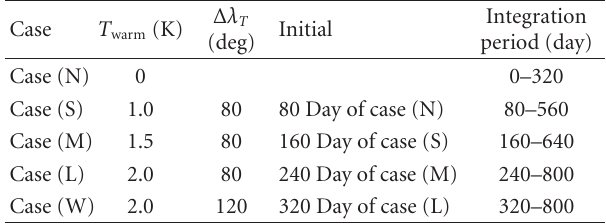
Table 3: Specification of five numerical experiments which are performed to examine the e ff ects of the warm